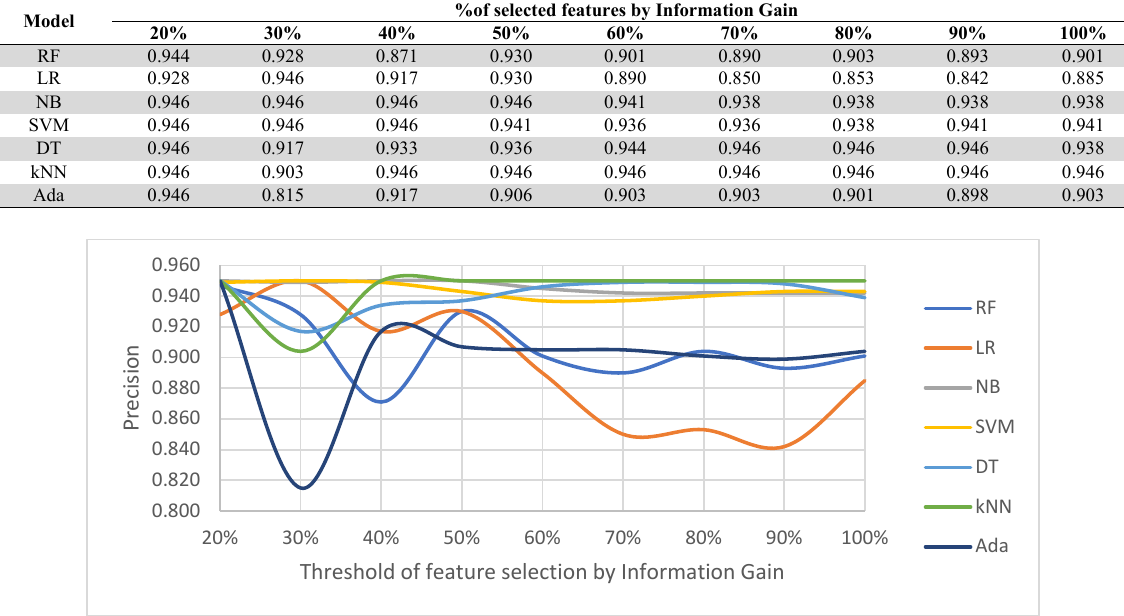
Results of Recall evaluation measure against different feature sets Model 20%